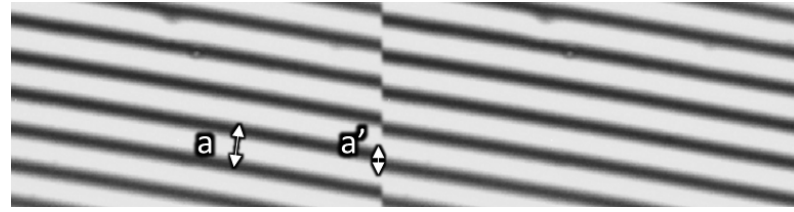
Figure 19. Microscopic image of interference bands.